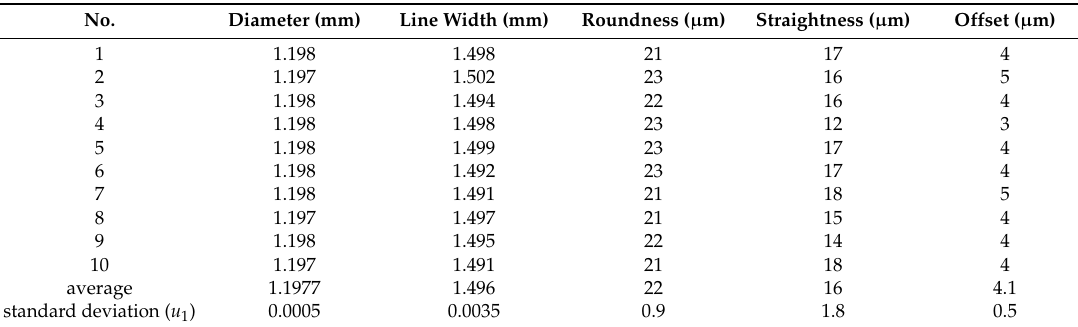
Table 12. Results of repeated measurement.